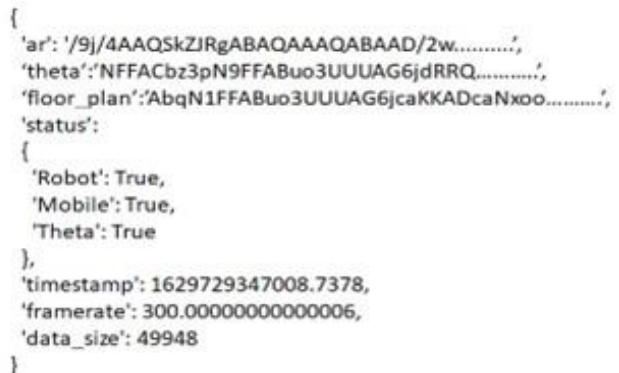
Figure 8. Sample JSON data sent from the robot node to the server.